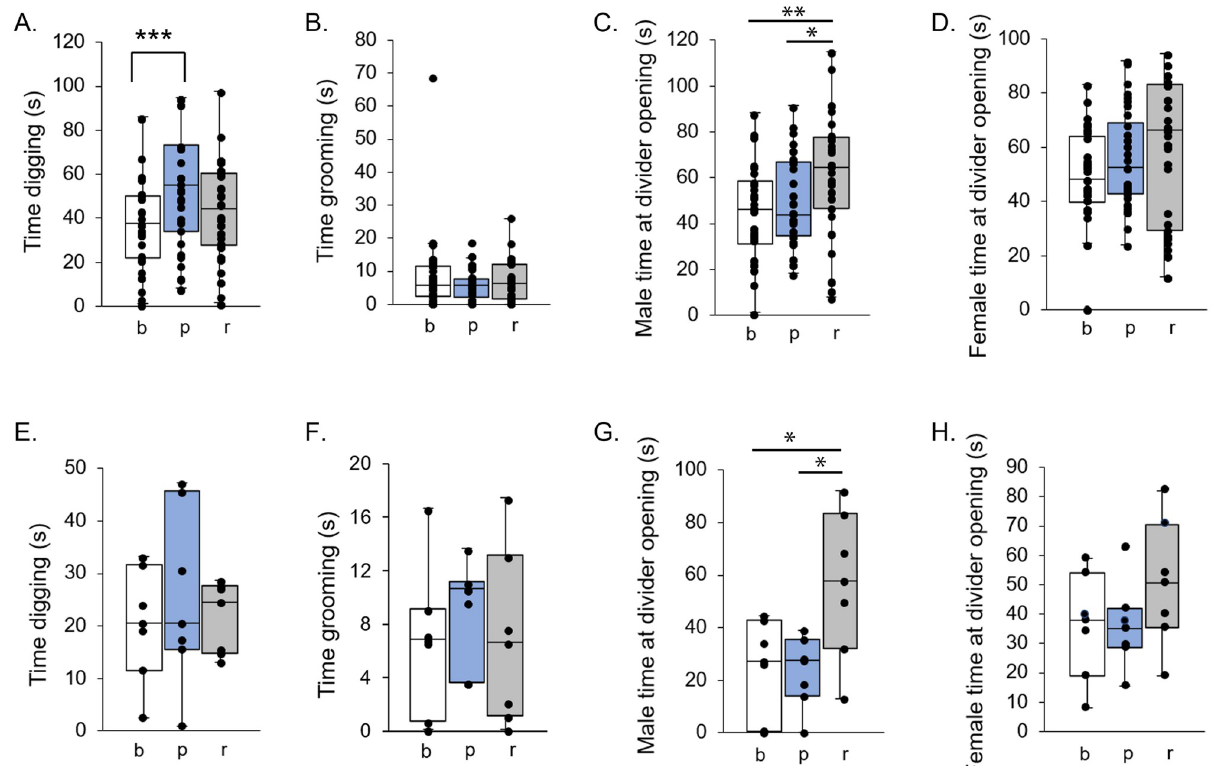
Fig 8. Effect of playback on nonvocal behaviors. Time spent digging (A. BBV Playback, E. White Noise) , time spent grooming (B. BBV Playback, F. White Noise) , time spent at the divider opening by males (C. BBV Playback, G. White Noise) and time spent at the divider opening by females (D. BBV Playback, H. White Noise) . A significant main effect of time period (baseline, b, playback, p, or recovery, r) was found for digging for BBV Playback. A significant main effect of condition (BBV Playback or White Noise) was found for digging and male time at the divider opening. Post-hoc comparison p-values are represented as � = p < 0.05; �� = p < 0.01; ��� = p < 0.001.